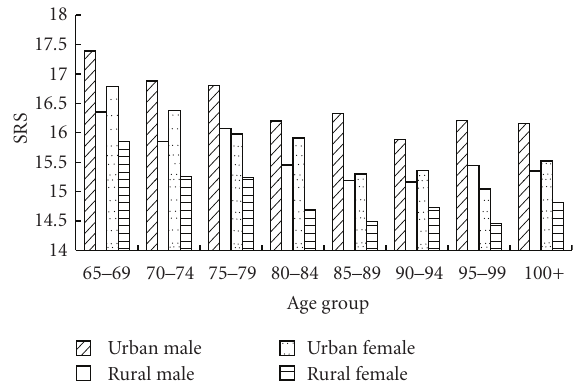
Figure 1: Average SRS by age groups, gender, and urban-rural